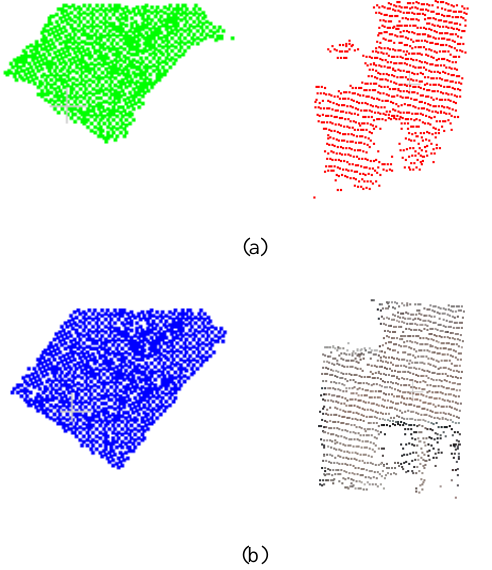
Figure 9: Building 1 segmentation of roof (left) and facade (right) (a) Proposed segmentation, (b) Manual segmentation